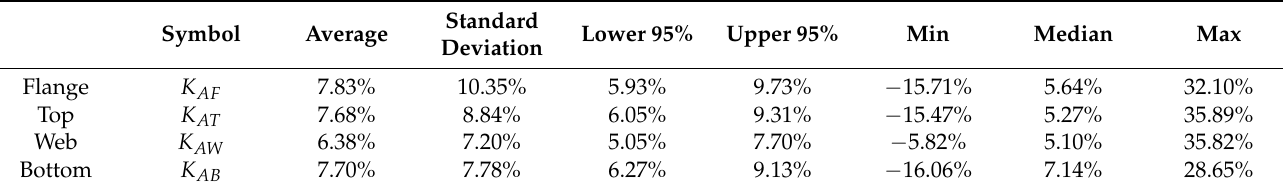
Table 6. Statistically analysis of K i of each part in the cross-section of bridge A.